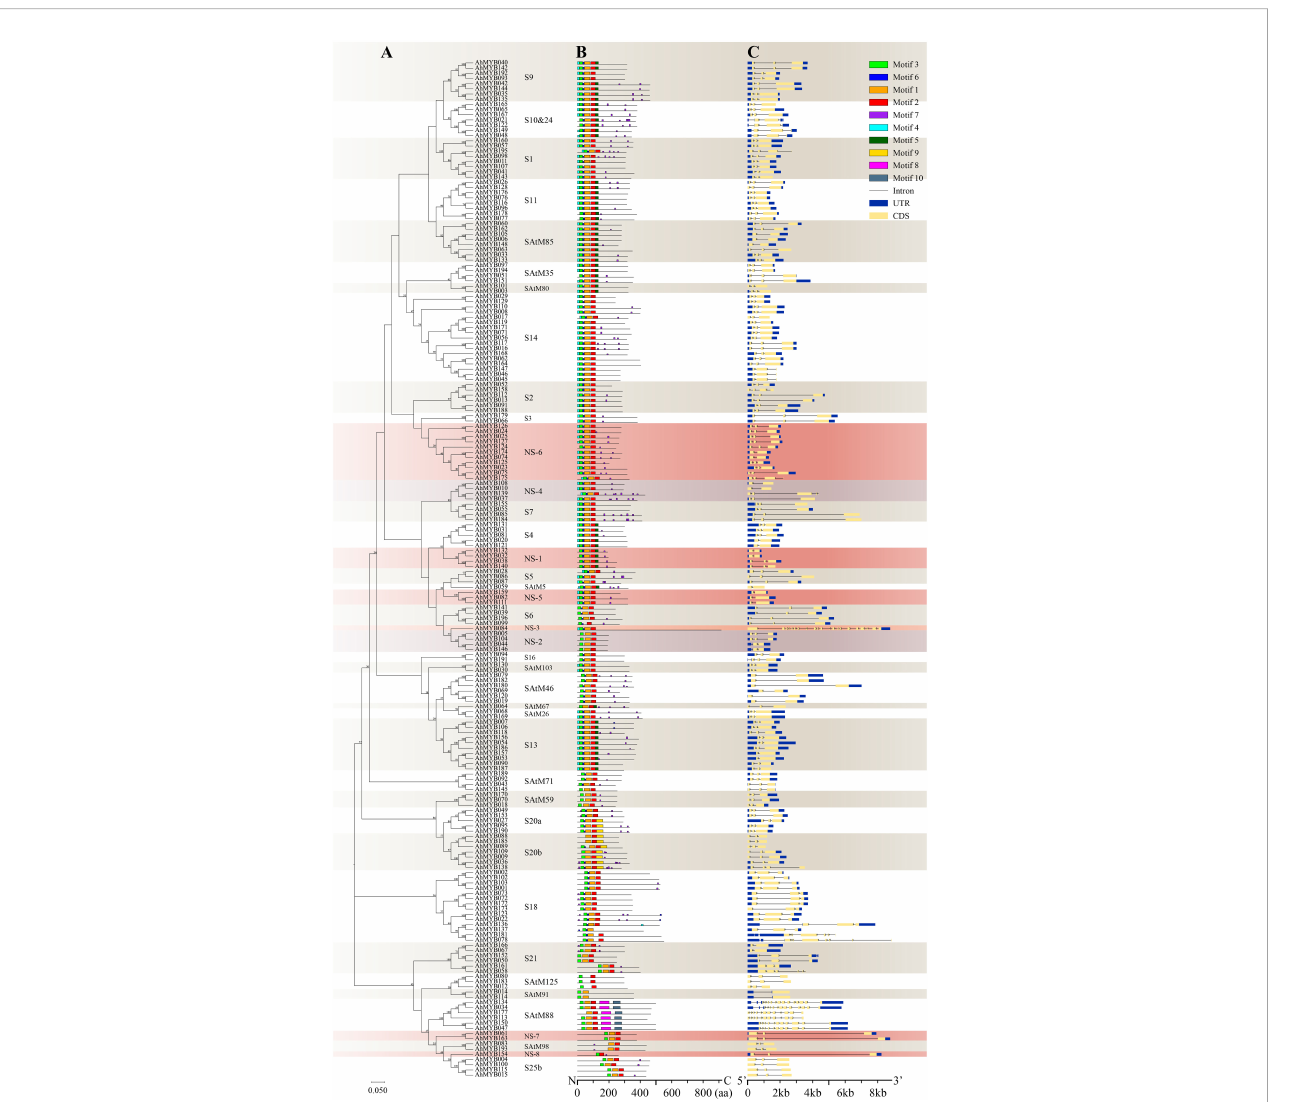
FIGURE 2 Phylogenetic relationships, conserved motifs, and gene structure analysis of peanut R2R3-MYBs. (A) The neighbor-joining phylogenetic tree was constructed by aligning the full-length amino acid sequences of 196 R2R3-MYBs in peanut. Coral and purple colors mark eight new subgroups, while beige and white indicate other subgroups. (B) The ten conserved motifs were shown in different colors and their speci fi c sequence information was provided in Supplementary Figure S5. (C) The yellow box, blue box, and black line in the gene structure diagram represented CDS, UTR, and introns,